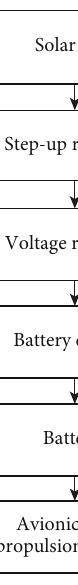
Figure 22: Block diagram with the step-up